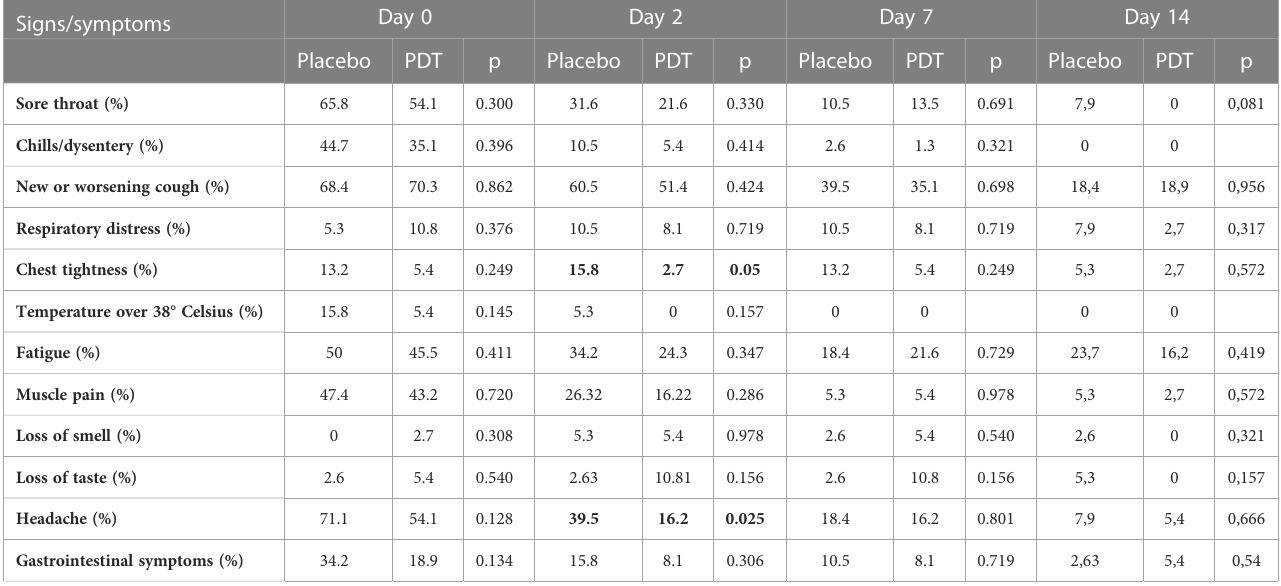
TABLE 3 COVID19 symptoms detected during the clinical trial.